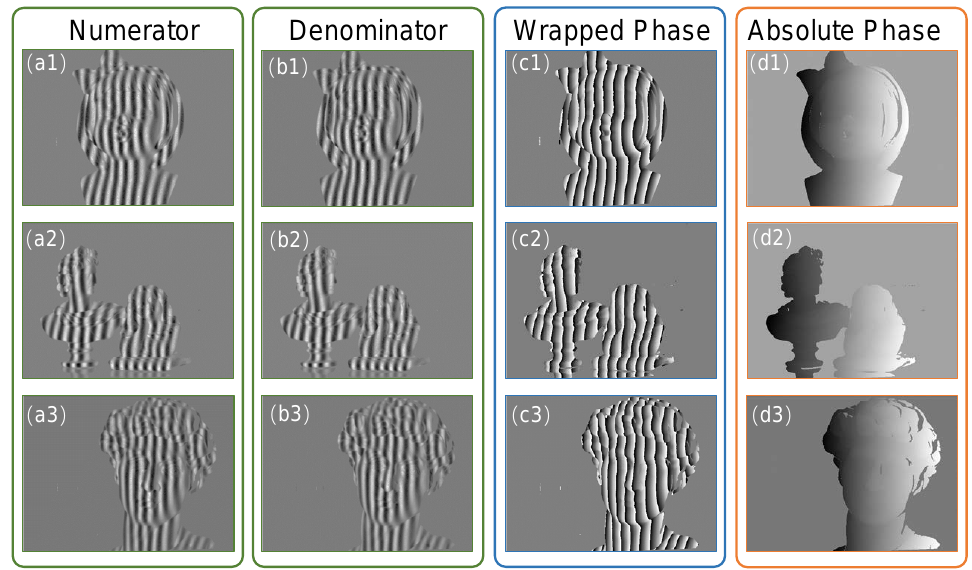
Figure 7. The numerator ( a1 – a3 ) and denominator ( b1 – b3 ) estimated by our method. ( c1 – c3 ) The wrapped phase calculated with numerator and denominator. ( d1 – d3 ) The absolute phase obtained by TPU using the wrapped